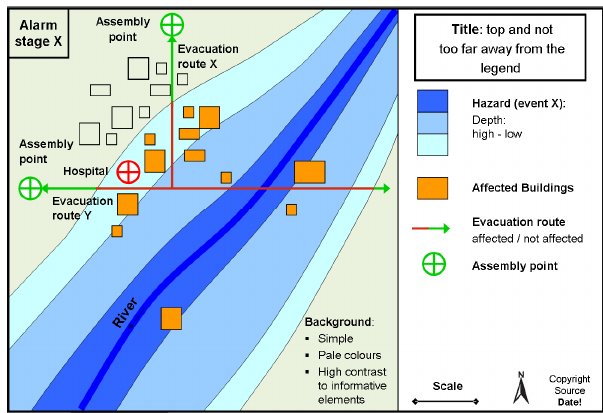
Fig. 7. Idealised map for the general public (based on and adjusted from Fuchs et al.,